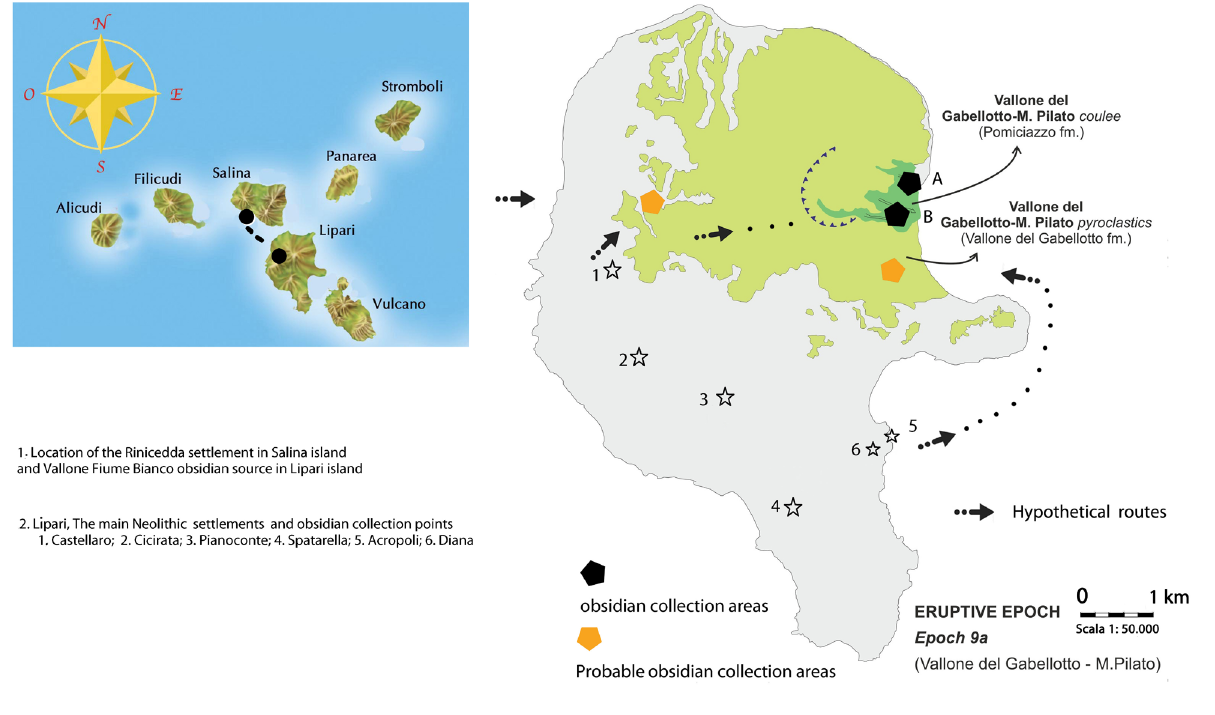
Figure 2: Lipari. Neolithic settlements and probable obsidian collection areas. In black the collection site of Papesca (A) and Lami (B). (Redrawn after Forni et al.,